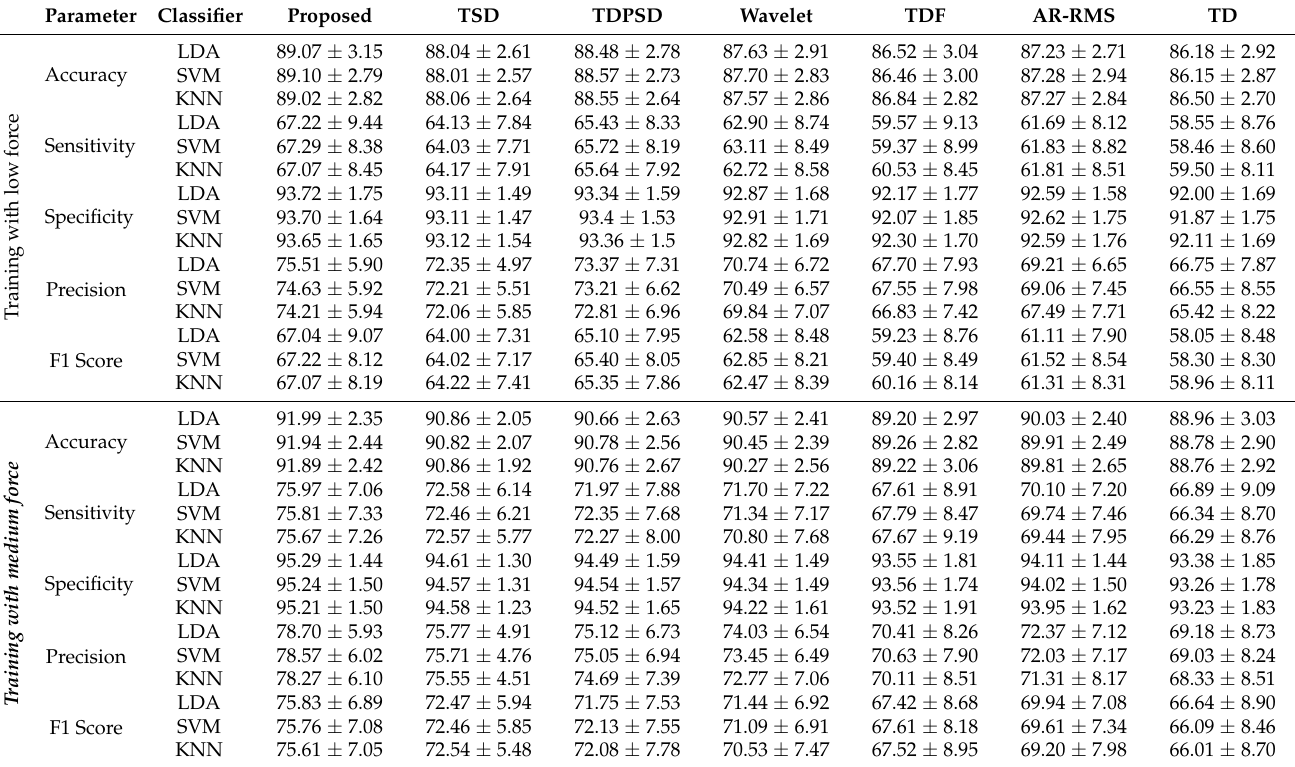
Table A2. The EMG pattern recognition performances when the classifiers are trained with a single force level and tested with all force